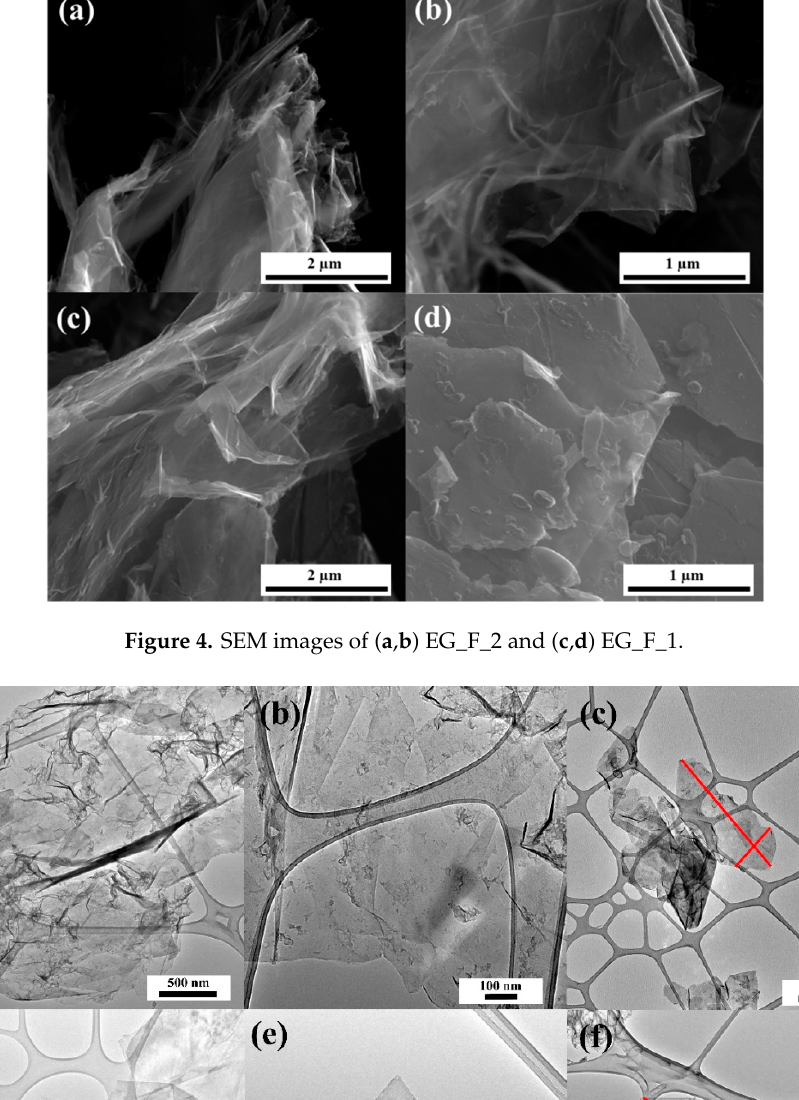
Figure 4. SEM images of (a, b) EG_F_2 and (c, d) EG_F_1.